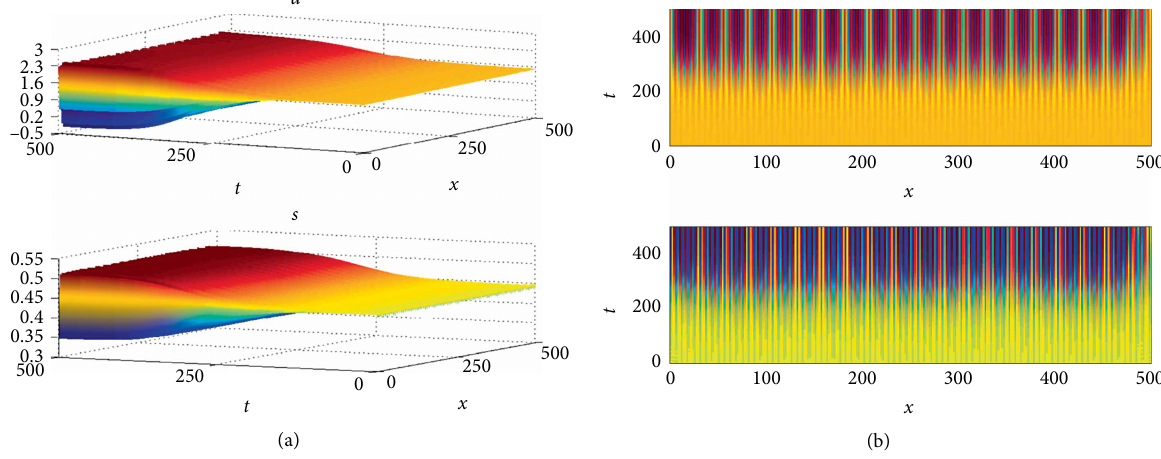
Figure 3: (a) The stable equilibrium projection of (a) in